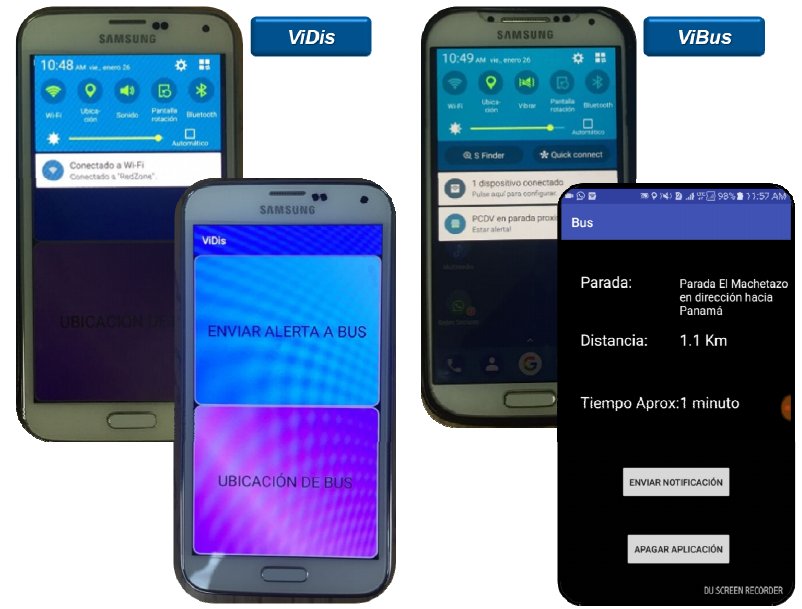
Figure 4. ViDis and ViBus mobile applications for Android OS [19,20,22].